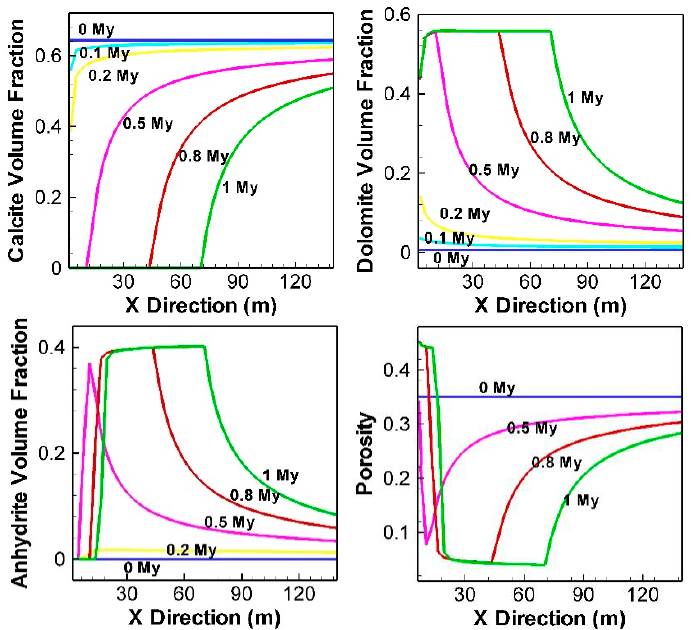
Figure 5. Calcite and dolomite content and porosity evolution (Case 1).